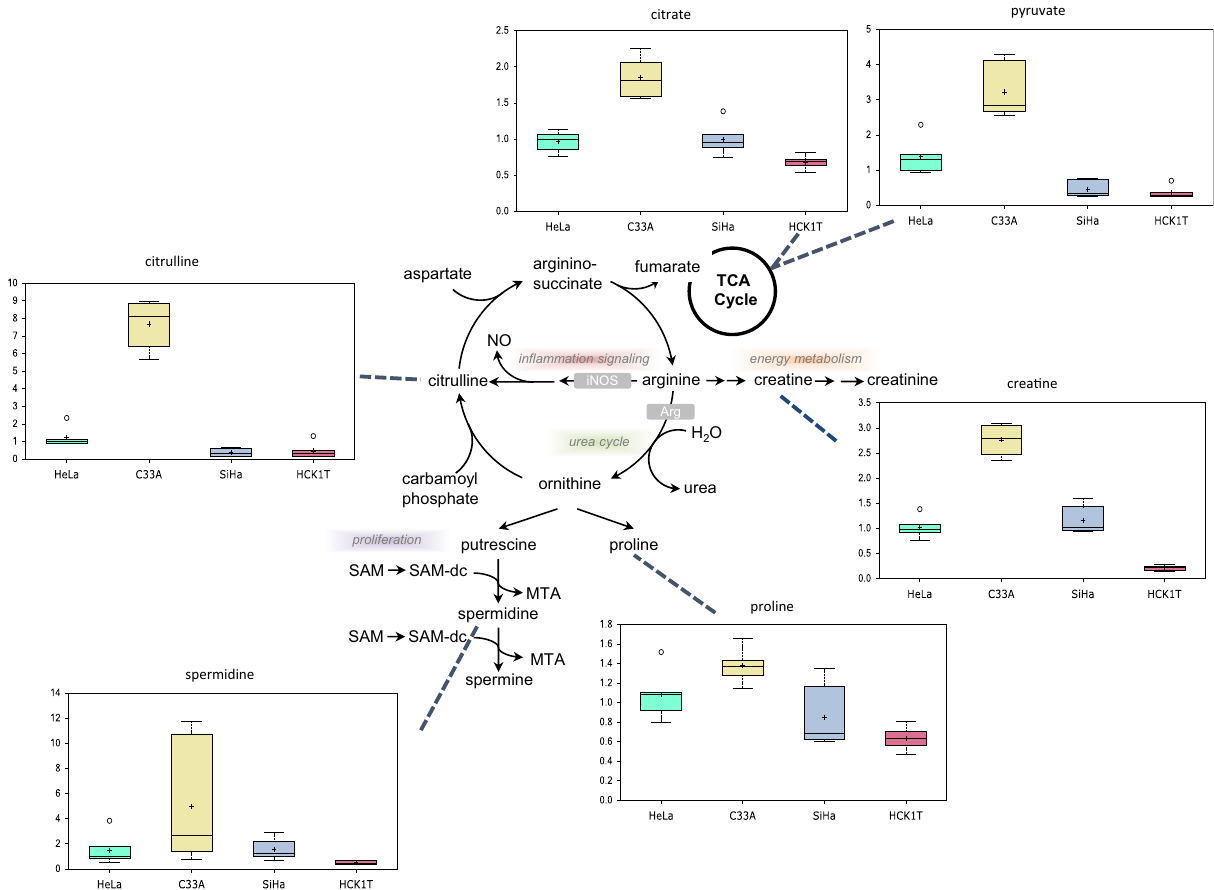
Figure 7. Metabolomic analysis of the arginine metabolism of the four cervical cell lines. C33A cells displayed potentiation of arginine metabolism. Biochemicals displaying salient changes among the four cell types are shown as box plots. Each box plot provides a measure of scaled intensity, normalised by protein content. The relevant pathway map of arginine metabolism is also